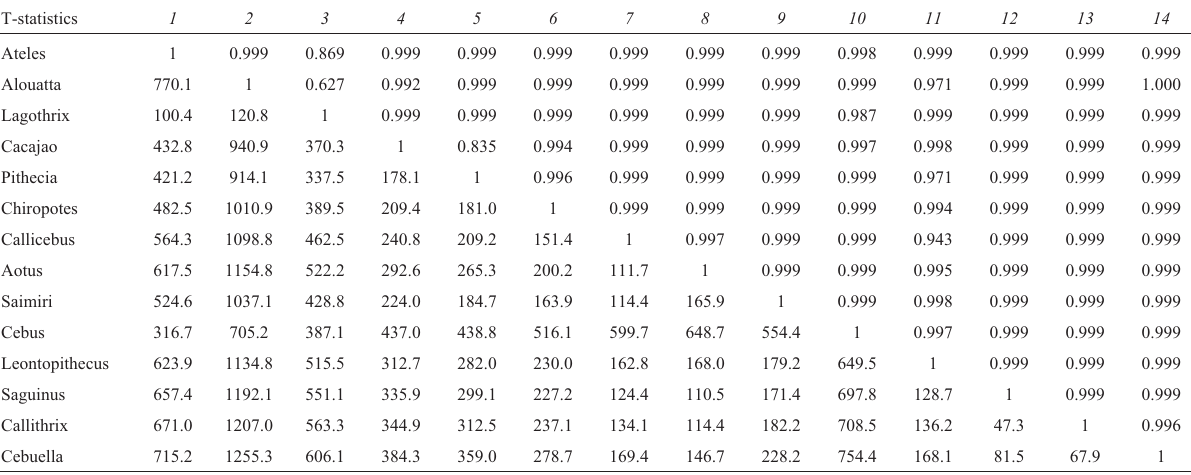
Table 4 - T-statistics results are show. Below the diagonal the observed T values and above the diagonal corresponding probabilities that the elements of the two matrices does not differ significantly.